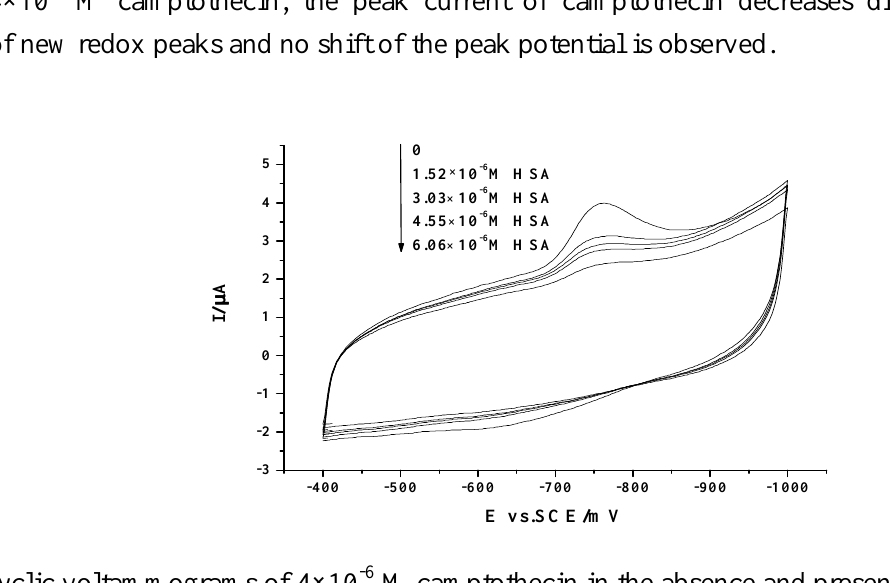
Figure 6. Cyclic voltammograms of 4×10 -6 M camptothecin in the absence and presence of HSA with different concentrations. Others same as in Figure